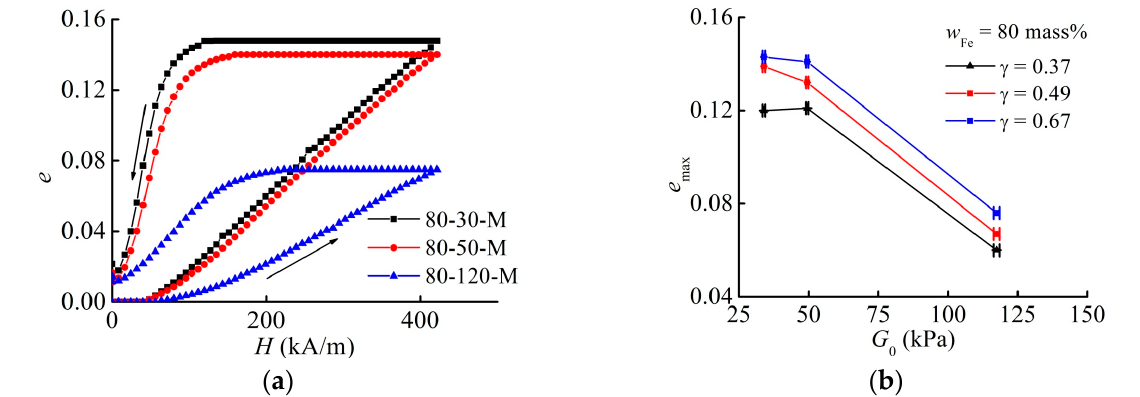
Figure 5. ( a ) Field dependence of the engineering normal strain of MAE samples with 80 mass% of iron and the middle aspect ratio on the shear modulus of the composite material. ( b ) Dependence of the maximum strain e max on the shear modulus for varied aspect ratio γ .